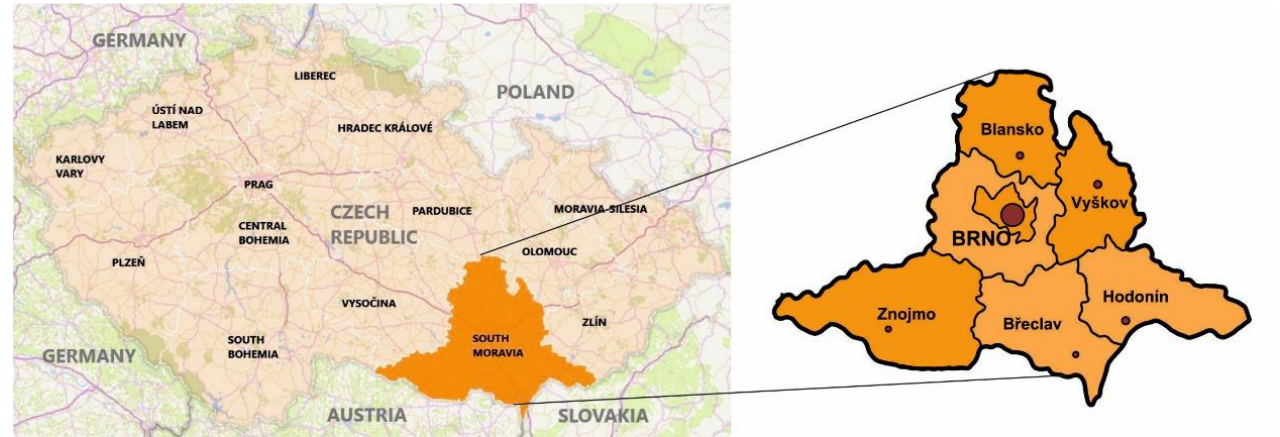
Figure 1. Area of the Czech Republic in which the in-depth analysis of traffic accidents is carried